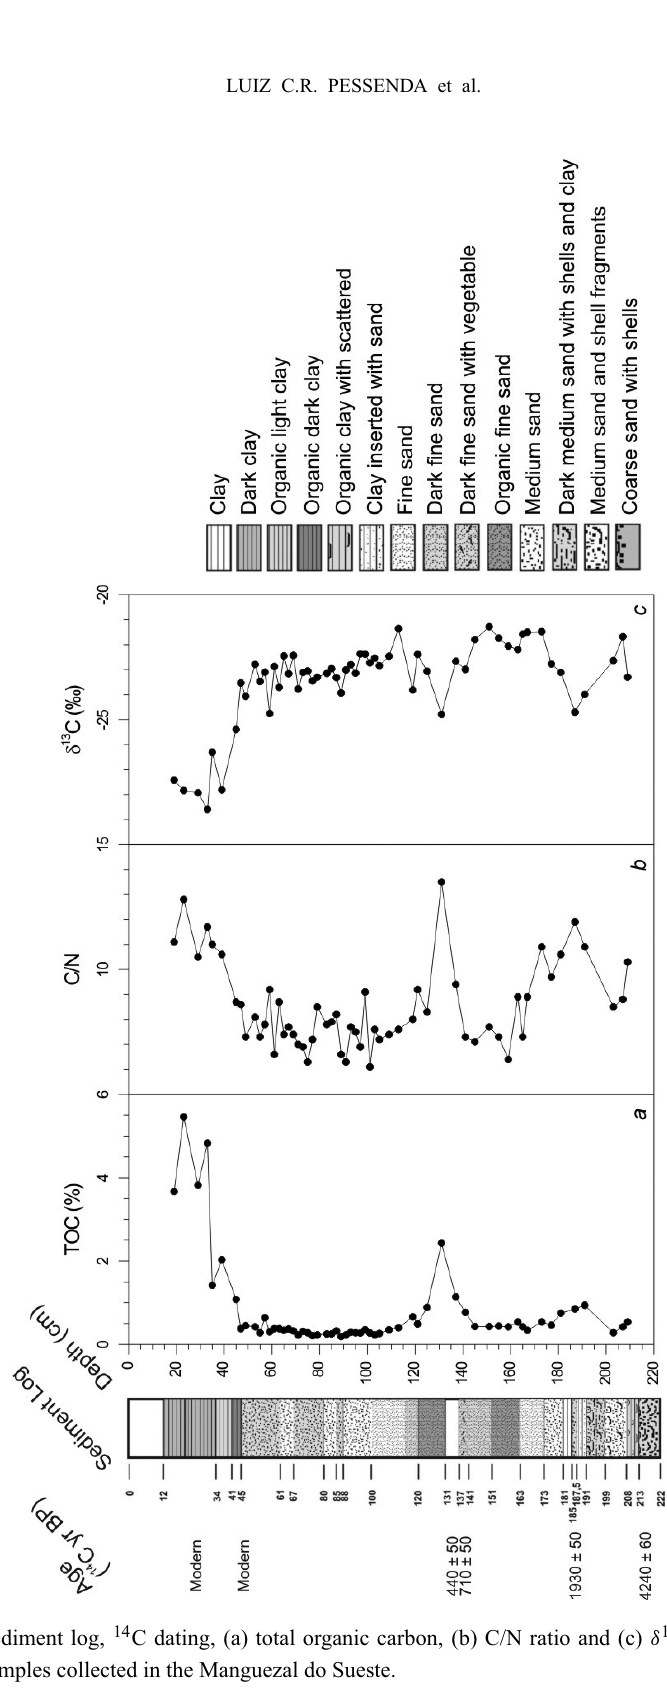
Fig. 5 – Sediment log, 14 C dating, (a) total organic carbon, (b) C/N ratio and (c) δ 13 C values of sediment samples collected in the Manguezal do